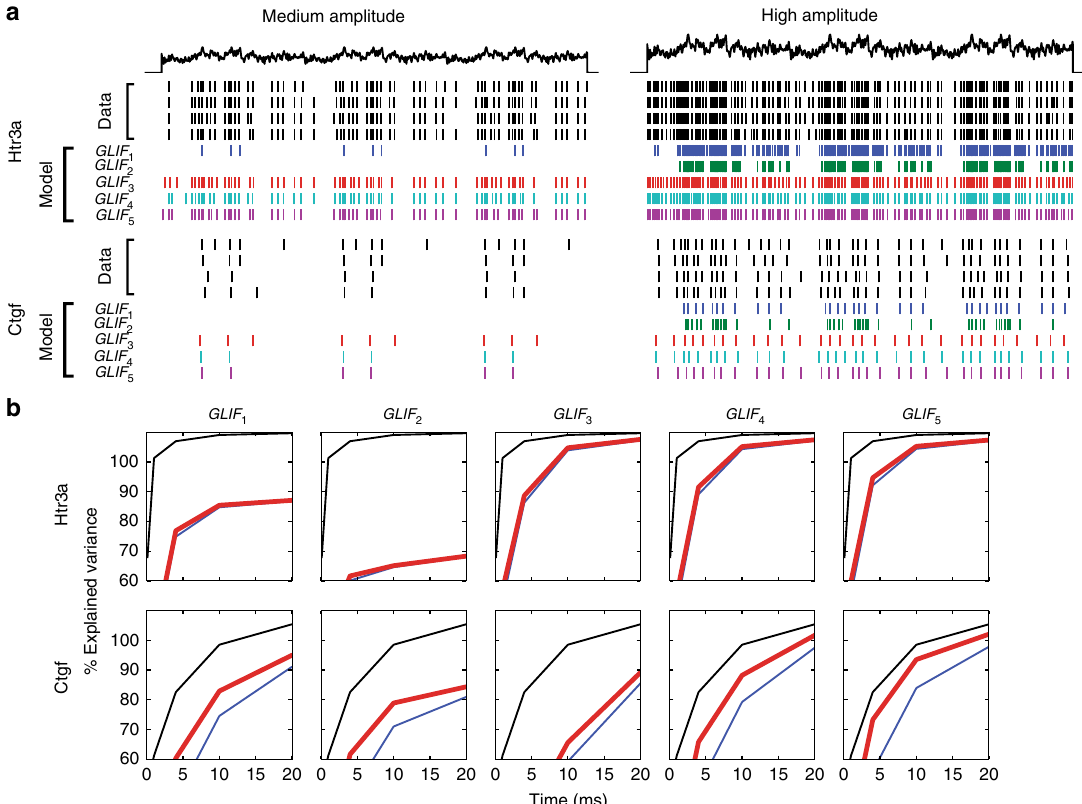
Fig. 4 Rastergrams and explained variance of biological data and all optimized model levels for “ hold out ” test data. a Data for the two example cells. Injected current shown in black. Black rasters are spikes from recorded neurons to repeated current injections. Colored rasters correspond to the fi ve different, deterministic models. The current injection is 3 s long. As GLIF 1 and GLIF 2 do not have a spike frequency adaptation mechanism (implemented by the summation of after-spike currents over many spikes in GLIF 3 ), they have trouble reproducing simultaneously the fi ring patterns at multiple input amplitudes. b Explained variance for the different model levels at different levels of time window resolution Δ t . The black lines represent the explained variance of the data (how well the neuron repeats its own spiking behavior). This trace would reach 100% if the spike times of the data were all exactly at the same time in each repeated stimulus: the fact that they are not 100% re fl ects the intrinsic variation in the spike times within the experimental data. The blue line illustrates the pairwise explained variance of the model with the data. Because the model can not be expected to explain the data better than the data can explain itself, the red line is the ratio of the pairwise explained variance of the model (blue) and the data divided by the explained variance of the data (black). This ratio value at a Δ t = 10 ms time bin is used for the explained variance performance metric in the main